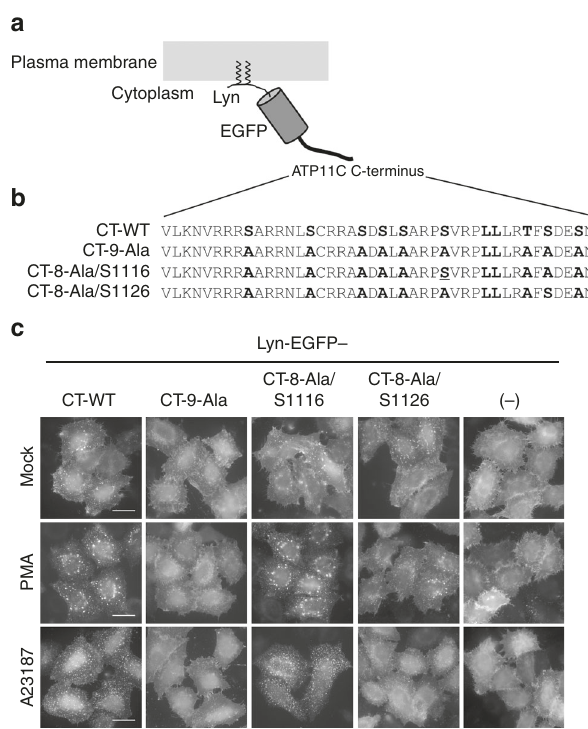
Fig. 7 Phosphorylation of Ser1116 containing the Leu1120/Leu1121 (pSVRPLL) motif is suf fi cient for endocytosis. a Schematic representation of chimeric protein. The plasma membrane targeting signal of Lyn and EGFP was fused to the C-terminal cytoplasmic region (CT) of ATP11C. b Amino acid sequences in the C-terminal cytoplasmic region (CT) of human ATP11C, which were fused to Lyn-EGFP as shown in a . c HeLa cells were transiently transfected with expression vector for Lyn-EGFP-tagged CT-WT, CT-9-Ala, CT-8-Ala/S1116, or CT-8-Ala/S1126, or the original vector encoding Lyn-EGFP-tagged FRB (FKBP – rapamycin-binding domain). The cells were treated for 15 min with vehicle alone (Mock), 400 nM PMA (PMA), or 1 μ M A23187 in the presence of 1.8 mM CaCl 2 (A23187), followed by fi xation. Scale bars, 20 μ